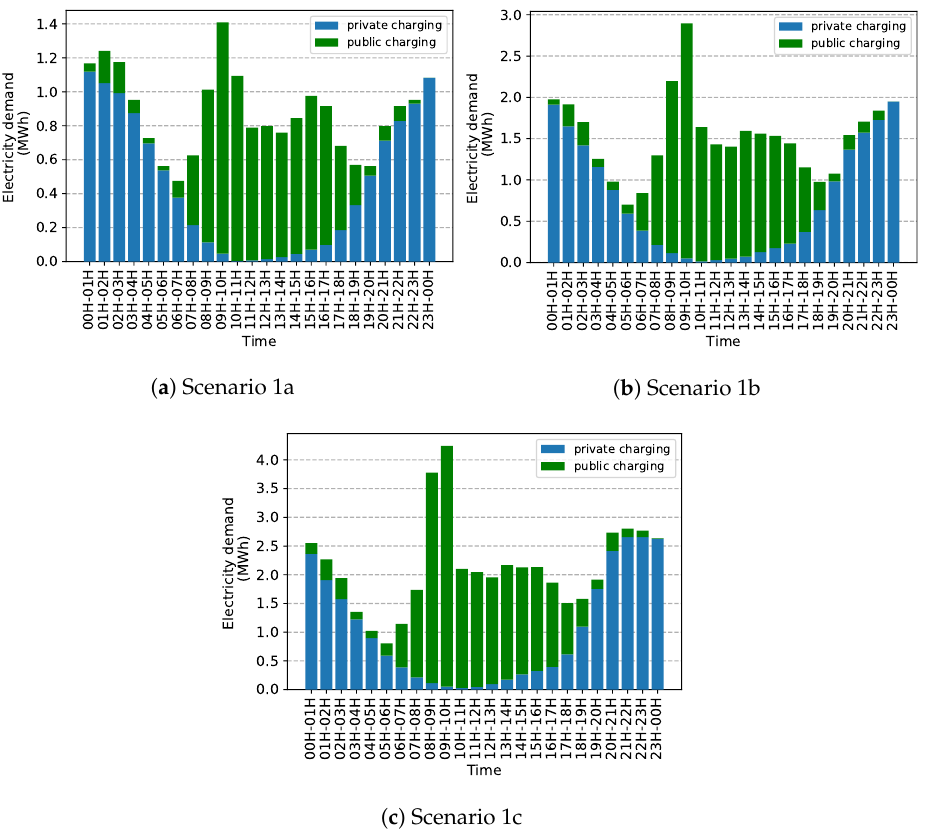
Figure 4. Aggregated hourly load profile due to EV charging for different scenarios at 2030 in the city of